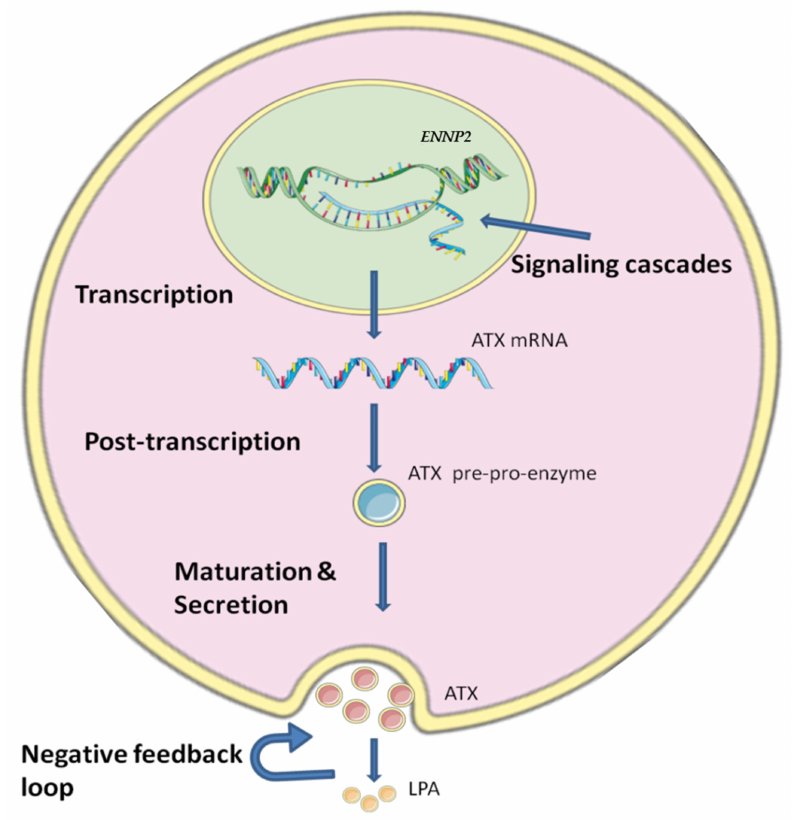
Figure 1. The regulatory levels of ATX’s expression and production. The expression of ATX is regulated in many ways. The first step of regulation for ENPP2 expression is during transcription by methylation and different transcription factors, growth factors and cytokines which can modulate ENNP2 expression by a diversity of signaling cascades. Then, at post-transcriptional level, a variety of factors act on ENNP2 mRNA affecting its stability and translation. Maturation and secretion also have an important role in regulating ATX, as a negative feedback loop is formed by ATX’s product LPA. The figure was prepared using SMART (smart.servier.com, accessed on 5 July